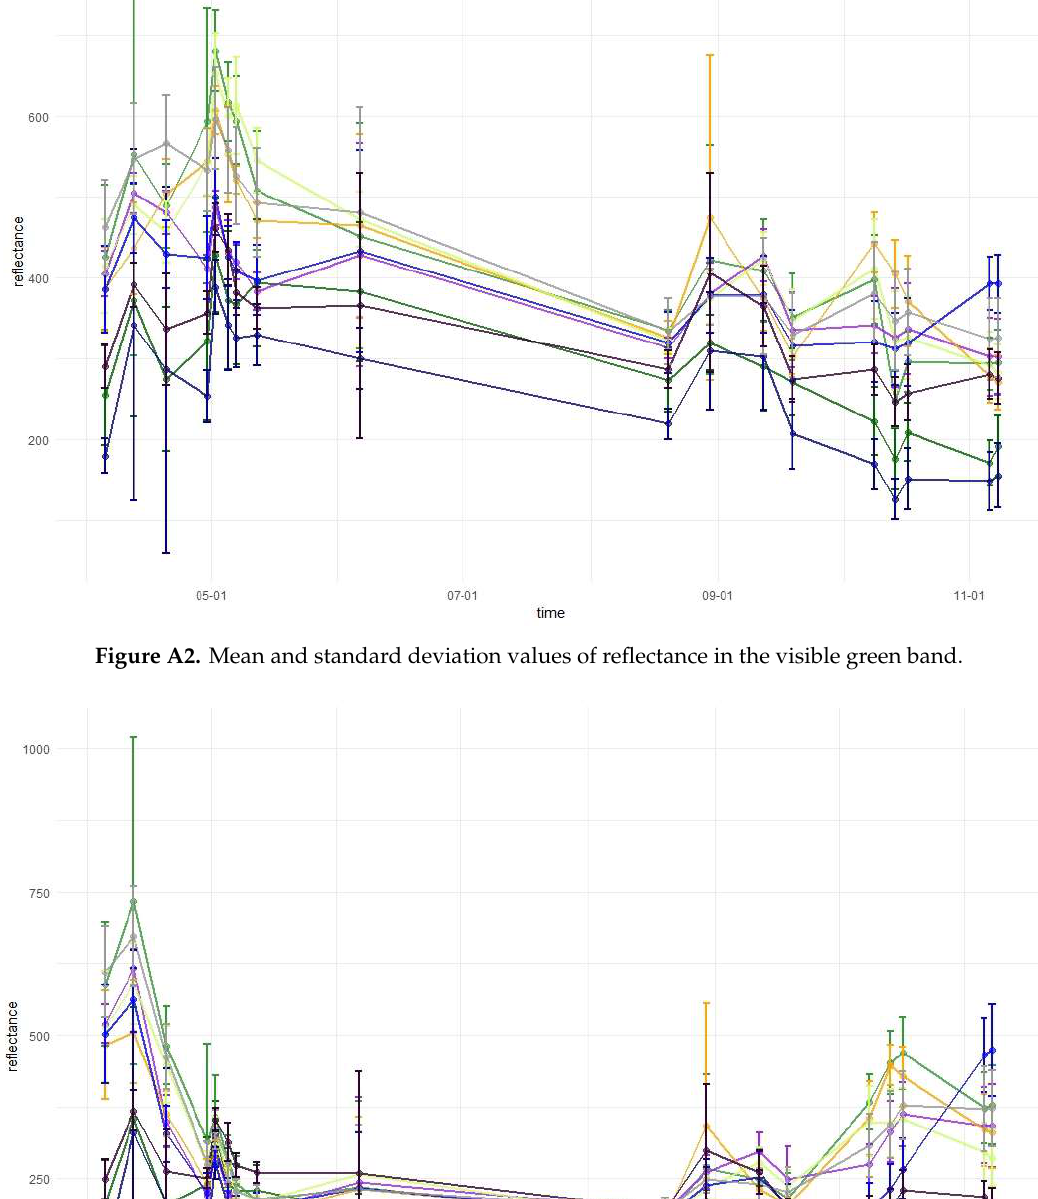
Figure A1. Mean and standard deviation values of reflectance in the visible blue band.